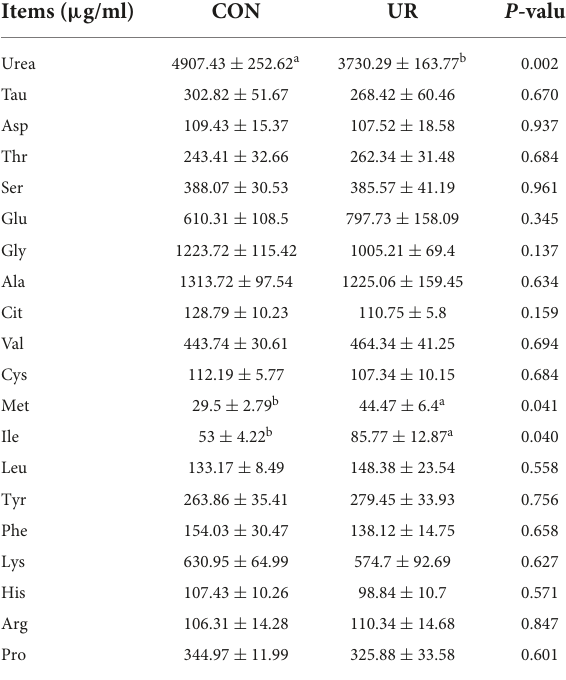
TABLE 5 Effects of UR on free amino acids profile in piglet